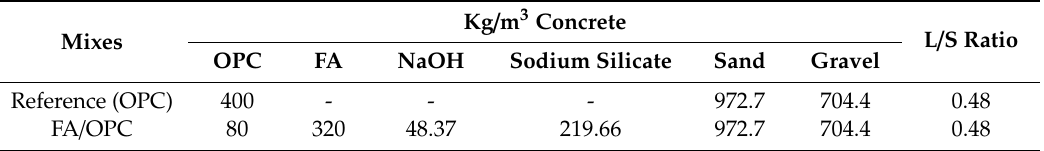
Table 5. Proportions of the components and liquid / solid ratio (L /